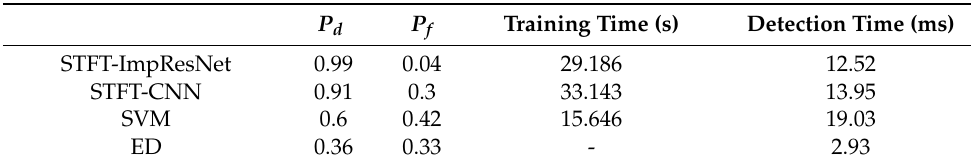
Table 3. Comparison of the detection efficiency.